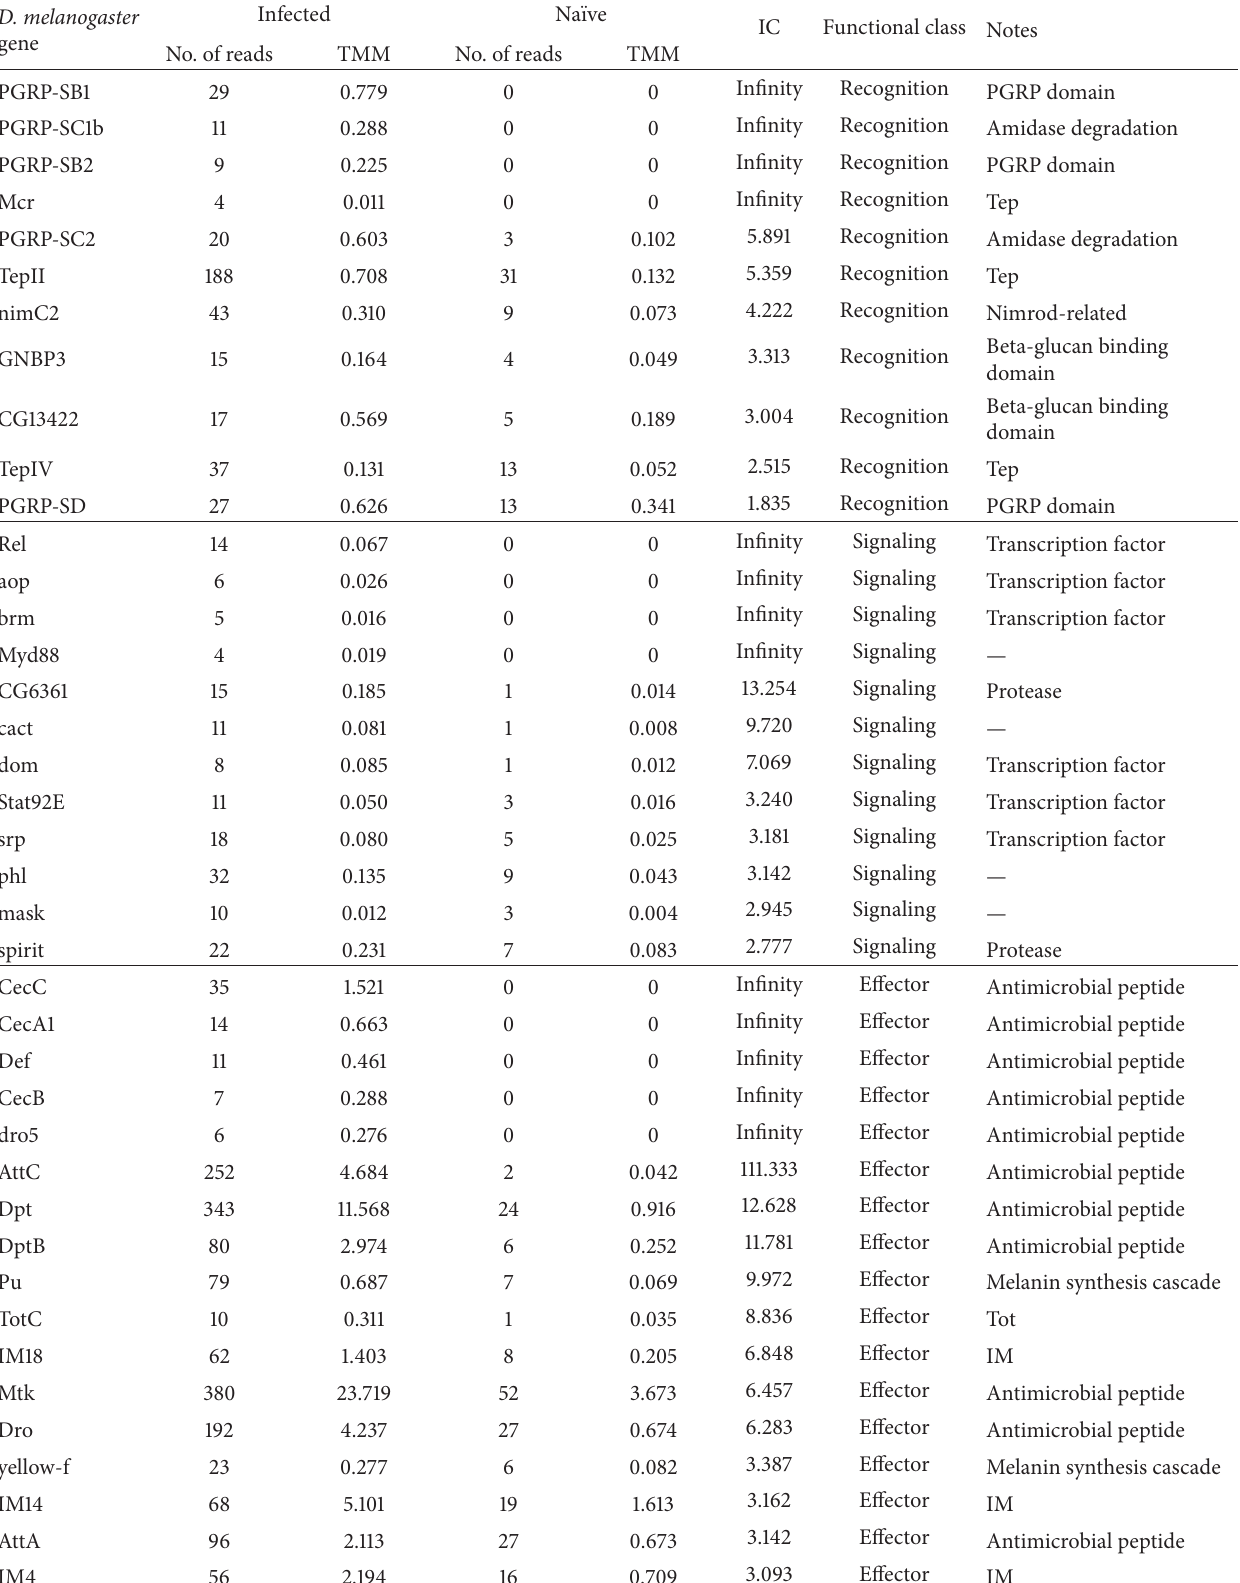
Table 3: Number of reads, trimmed mean of M value (TMM), and induction coefficient (IC) for recognition, signaling, and effector class immune genes showing significant changes in expression level by fungal infection in D. melanogaster